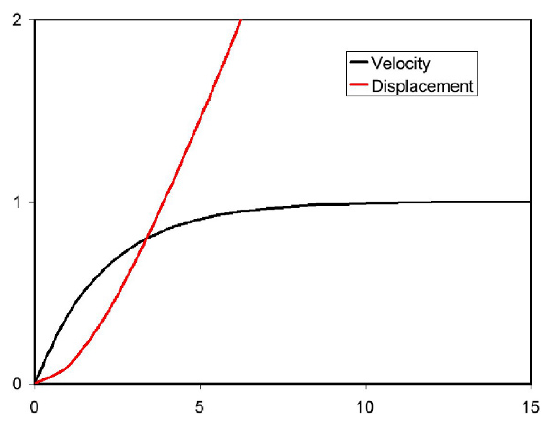
Figure 12. Motion of the front facesheet under a step pressure load as a function of time (in µs ). Non-dimensional velocity vz c p o and non-dimensional displacement uz c / ( p